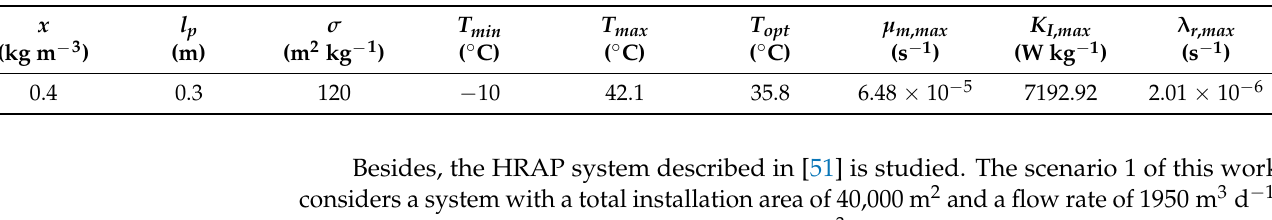
Table 3. Experimental